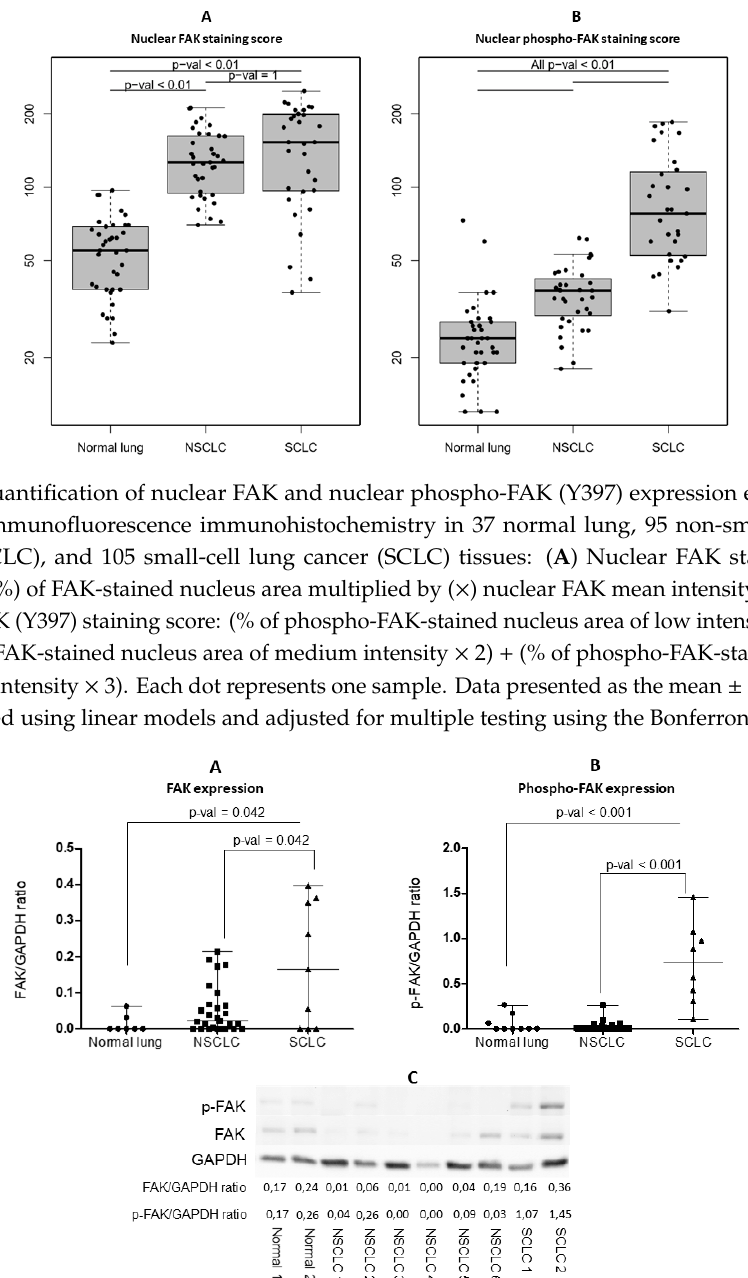
Figure 5. Quantification of ( A ) FAK and ( B ) phospho-FAK expression evaluated by Western blot (WB), with normalization to glyceraldehyde 3-phosphate dehydrogenase (GAPDH ) expression, in nine normal lungs, 30 non-small-cell lung cancer (NSCLC), and 10 small-cell lung cancer (SCLC) tissue lysates. Each dot represents one sample. Data presented as the mean ± S.D. Significance determined by the Kruskal-Wallis test. ( C ) Illustration of a representative WB of FAK and phospho-